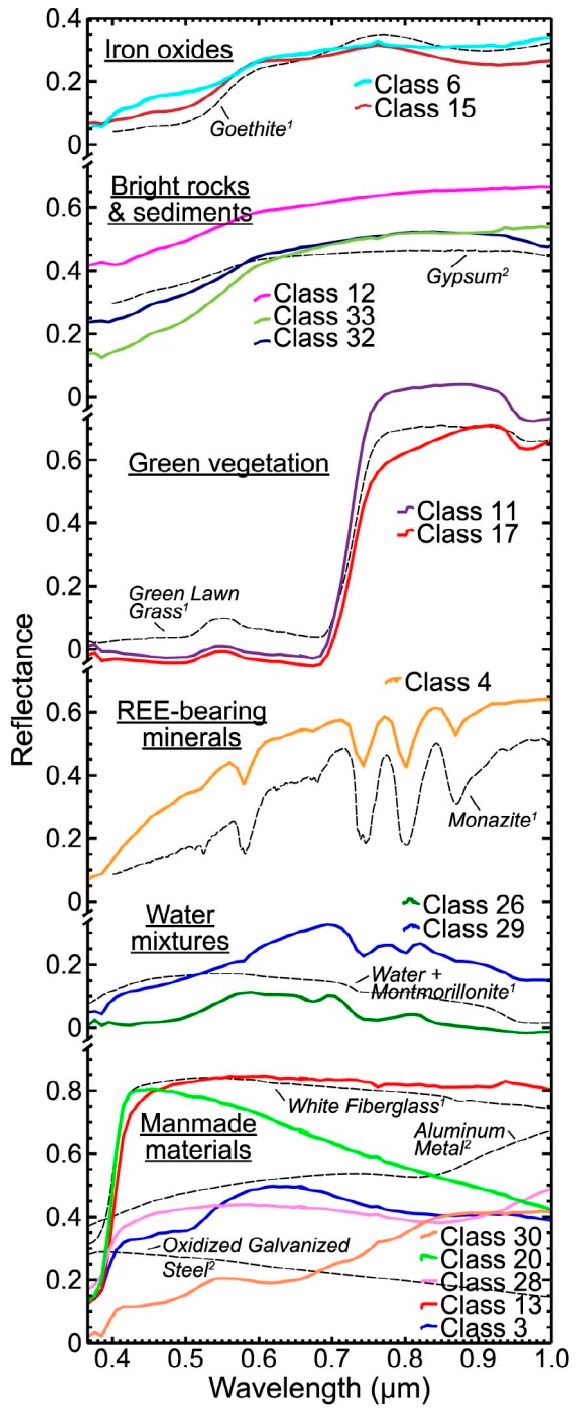
Figure 5. Selected visible to near infrared (VNIR) image endmember spectra and example reference spectra. 1 USGS Digital Spectral Library [61]; 2 ASTER Spectral Library [62].